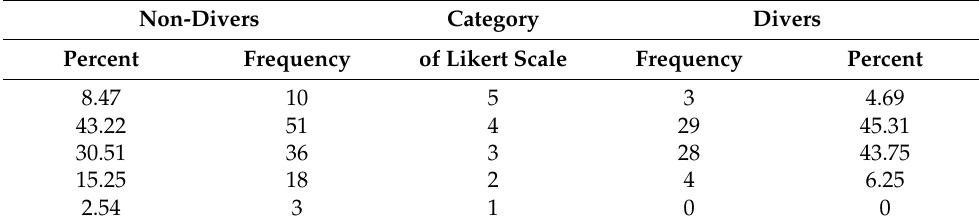
Table 7. Scuba diving impact on the improvement of muscle strength.